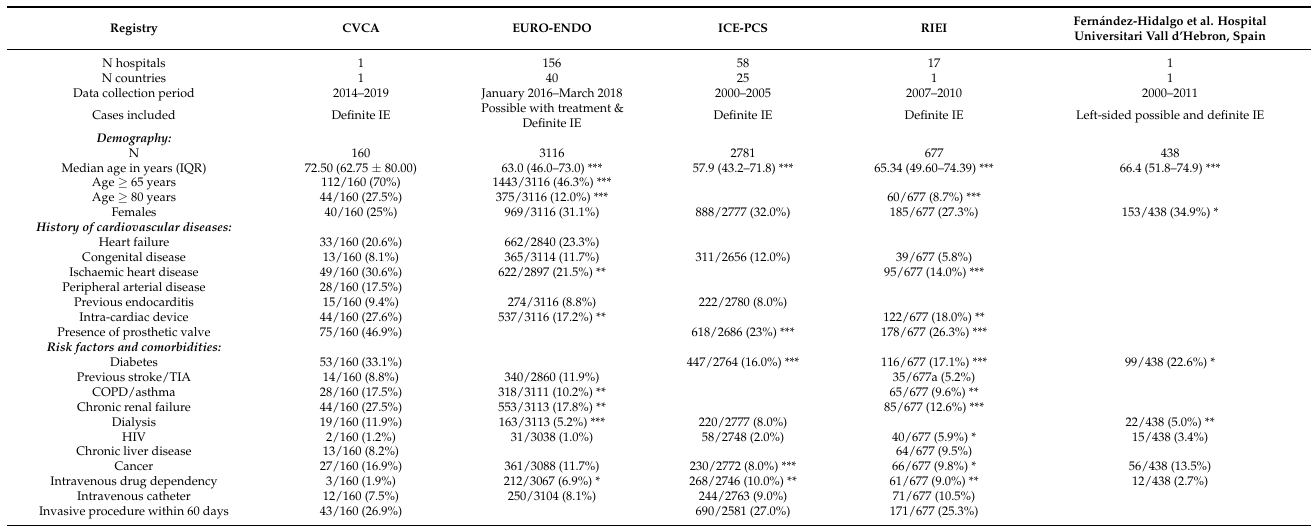
Overview of basic study specifications, demography, cardiovascular disease history, risk factors and comorbidities in the five samples. Cell markings with asterisks represent the statistical significance levels of the two-sample Pearson’s chi-squared tests for the observed proportions and of the one-sample Wilcoxon rank sum tests for the medians. Reported significance levels for pairwise comparison between OLV Hospital and each of the four other registries individually are the following: no asterisks marking given for p >= 0.05, * for p < 0.05, ** for p < 0.01 and *** for p < 0.001. Table A2. Clinical presentation.